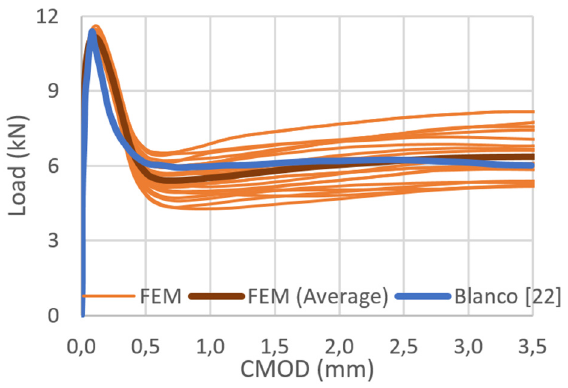
Figure 2 . Experimental [27] and numerical results.